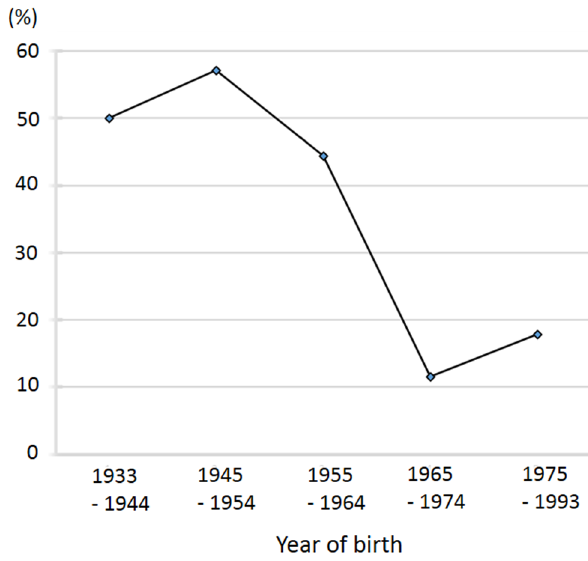
Figure 2. Proportions of patients with Helicobacter pylori infection by year of birth. Among the MS patients, the proportion of patients with H. pylori decreased markedly in those born after 1965. MS, multiple sclerosis.